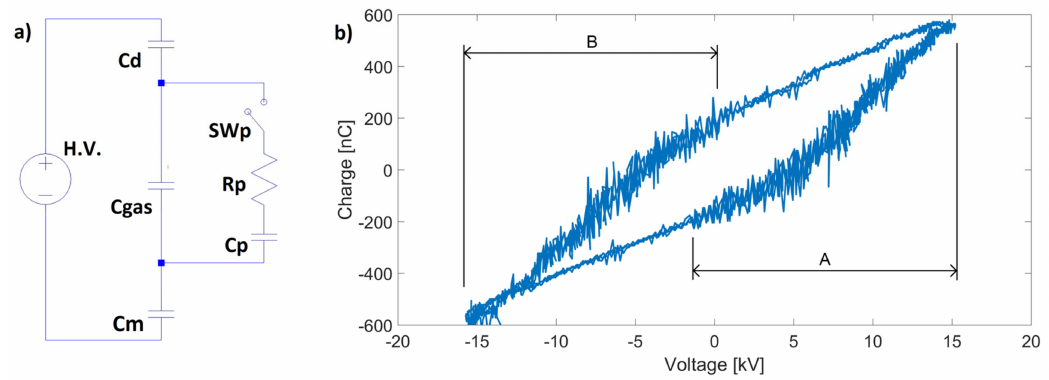
Figure 5. ( a ) DBD equivalent electric circuit with the presence of measurement capacity Cm and ( b ) Lissajous figure used for the average power